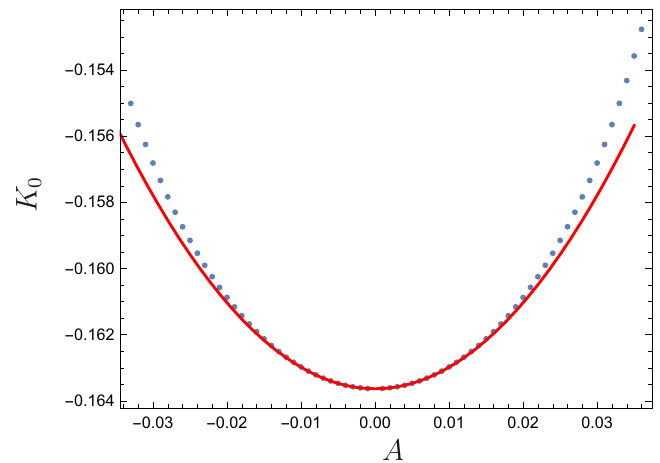
Figure 13 . We construct TypeA b background geometry parameterizing it with A , defining the deviation from the critical point H , see (D.2). The same geometry was parameterized with crit 3 K 0 in [17]. Dots represent K 0 ( A ) for select values of A . The solid red curve is the perturbative approximation